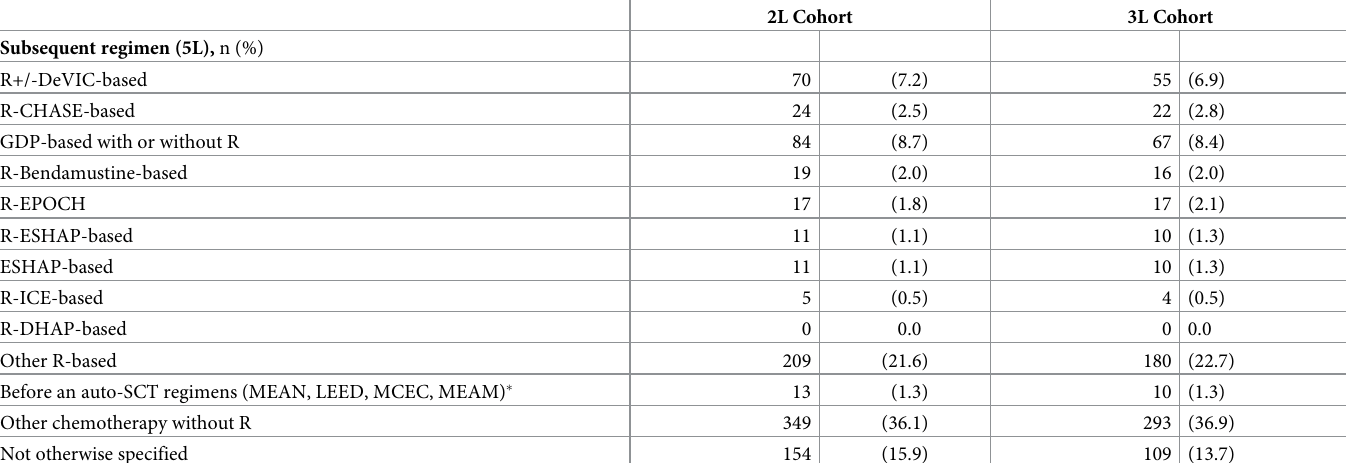
increase in cost burden in the 3L cohort ( β : 0.116 [95%CI: 0.059, 0.172]). Parameters associated with significant decrease in burden of cost included female gender ( β : -0.034 [95%CI: -0.061, -0.007]), older age groups (71 years or older) compared to those under 66 years, and increasing index year of treatment ( β : -0.117 [95%CI: -0.144, -0.090]). CCI score was not significantly associated with total effect on medical cost. This model fit the data well with a SRMR of